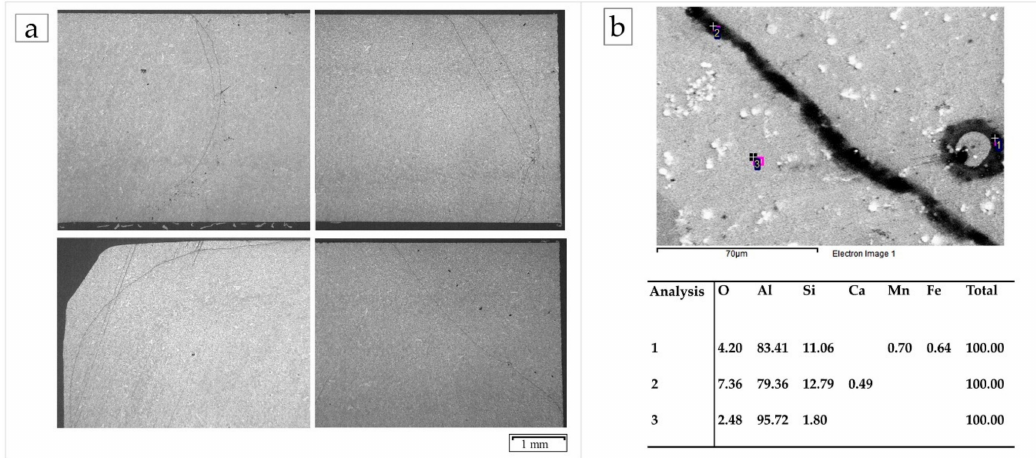
Figure 15. ( a ) Optical micrographs of defects revealed by liquid penetrant testing; ( b ) SEM observation with EDS analysis of this